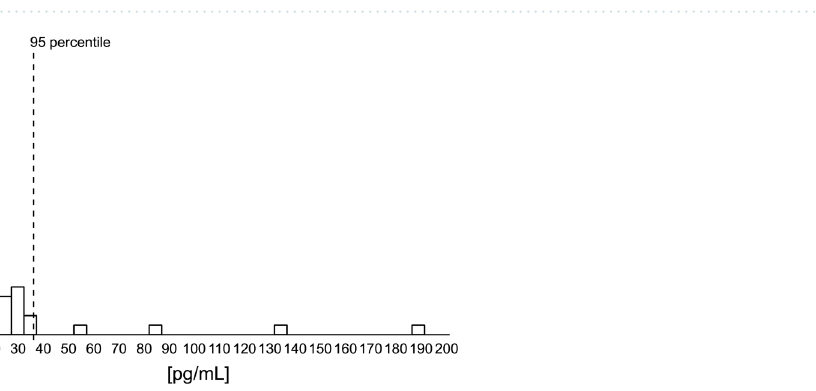
and haemoglobin (46.0 g/L), conjugated bilirubin (BIL-F; 3450 µmol/L), unconjugated bilirubin (BIL-C; 3540 µmol/L), chyle (17,700 FTU), purified RF (500 IU/mL), and 100 μg/mL of various drugs (bottom).